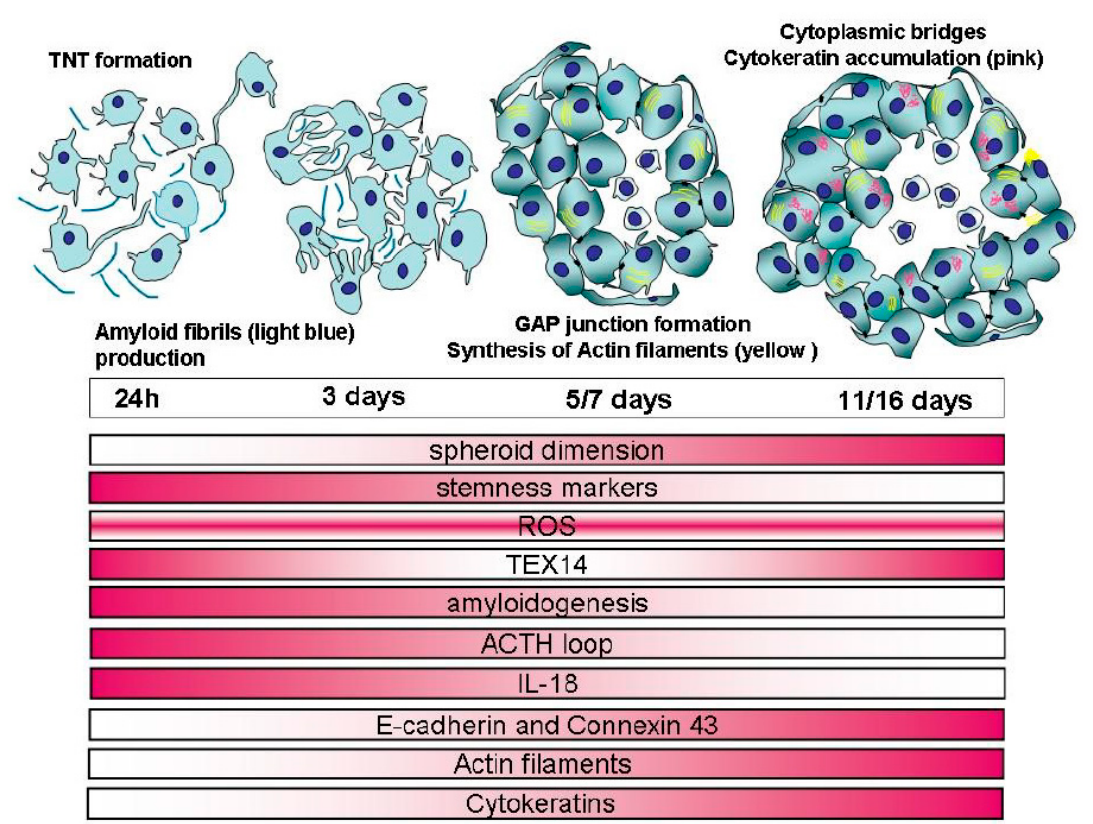
Figure 9. Graphical view of spheroid formation with the principal morphological evidences (TNTs, amyloid fibrils, gap junctions, actin filaments bundles, and cytokeratins accumulations). In the lower panel, the repertoire of the specific cellular events is represented with red color code, with color gradients corresponding to the time points.